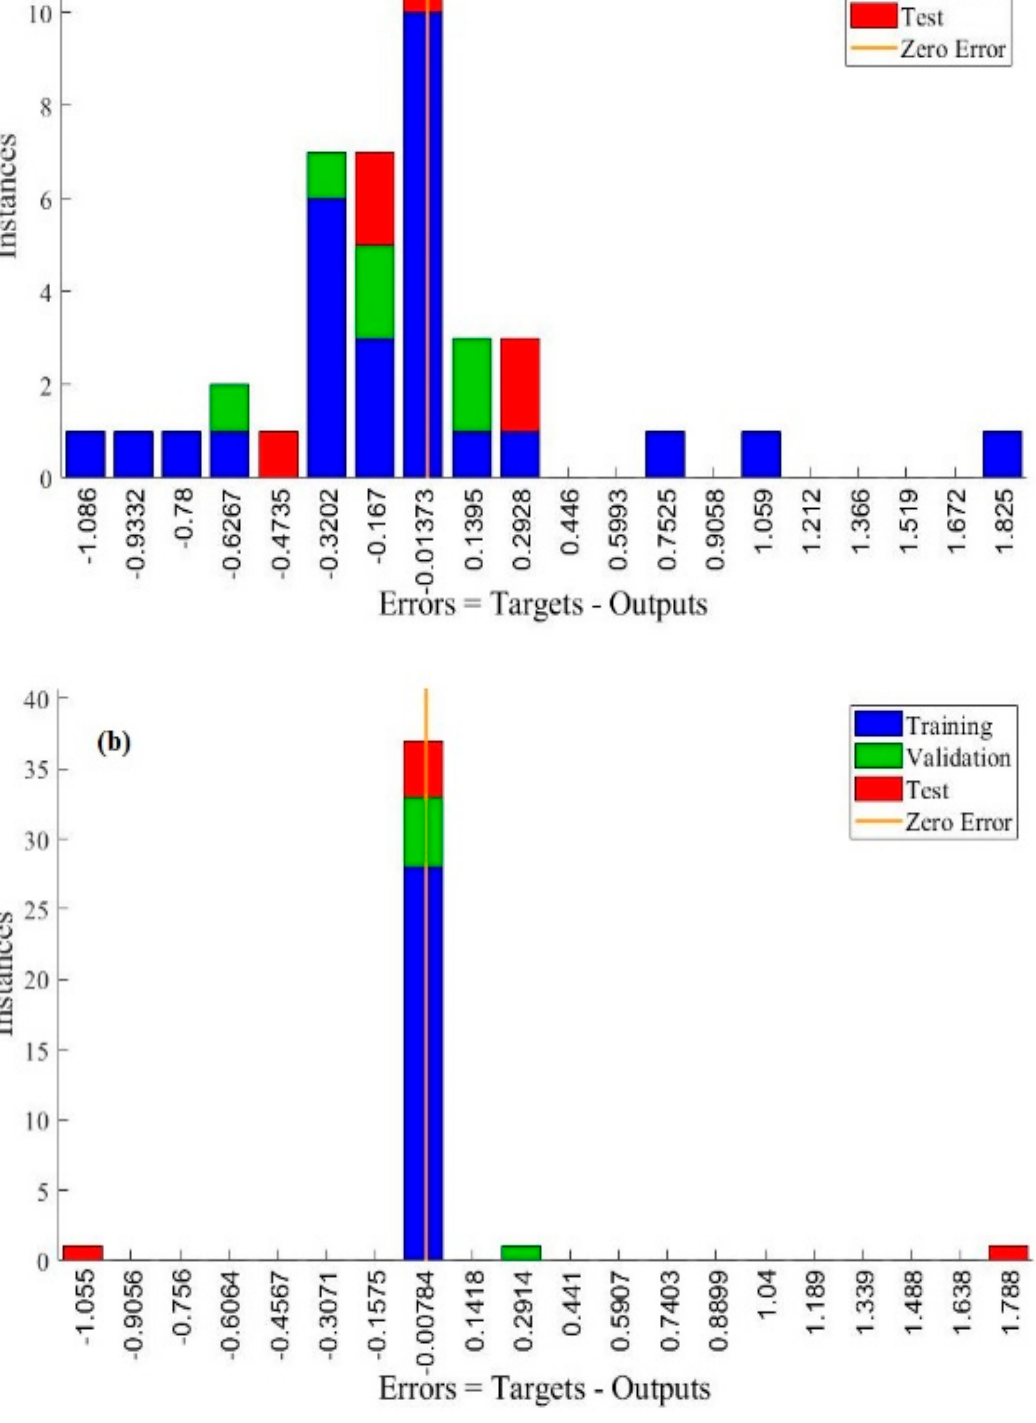
Figure 5. ( a , b ). Error histogram of the ANN model for M = 0 and M =